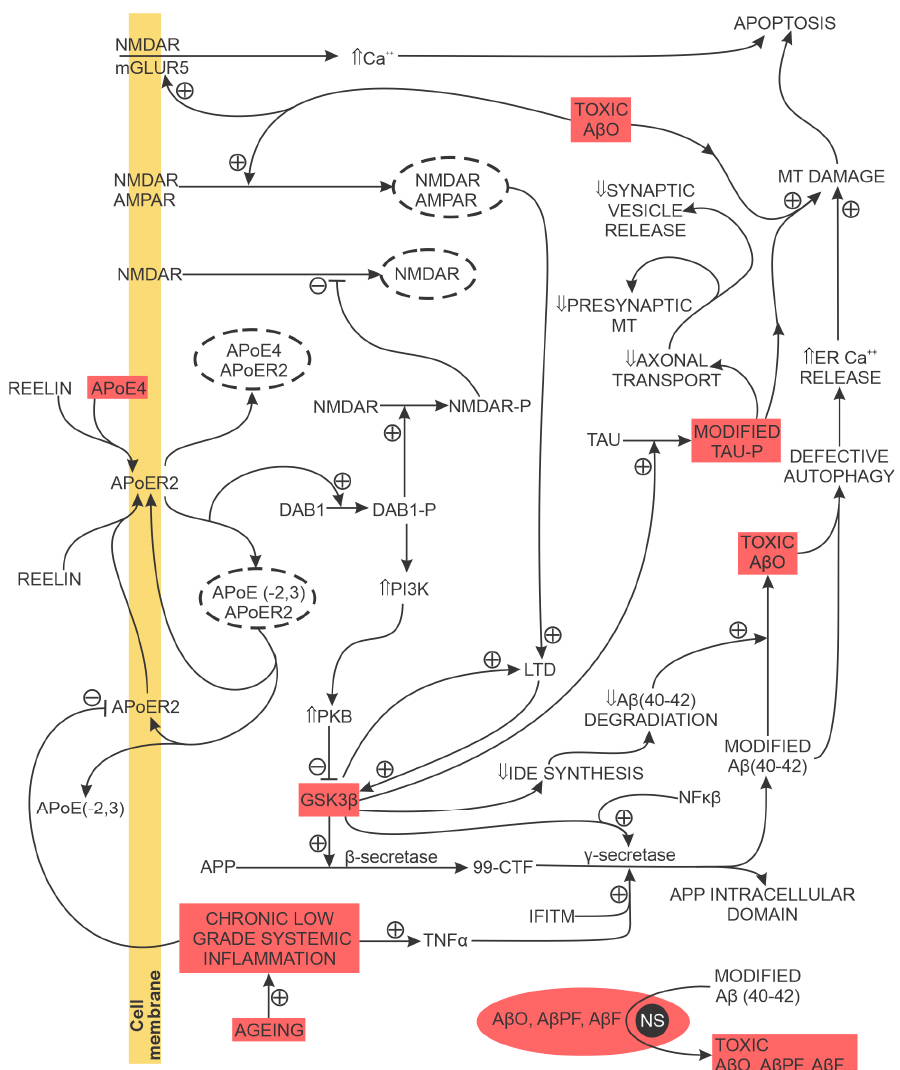
Figure 4. Toxic soluble A β O and truncated, misfolded, and hyperphosphorylated toxic tau oligomers are the critical drivers of synapse loss and neuronal death in AD. The transformation of normal tau to its toxic oligomers is promoted by increased GSK3 β activity; GSK3 β inhibits A β 42 degradation and promotes A β 42 production by stimulating β - and γ -secretase activity. Increased TNF α and IFITM levels also promote high GSK3 β activity. Ageing-associated chronic low-grade sterile inflammation and reduced reelin synthesis facilitate A β metabolism dysregulation. The secondary nucleation processes further accelerate the conversion of A β 42 peptides to toxic A β Os at the A β O, protofibril and fibril nucleation sites. Abbreviations: ⇑ (increased), ⇓ (decreased), + (stimulating effect), − (inhibitory effect), - - - - (dashed lines denote internalised molecules), 99-CTF (99-amino acid membrane-bound C-terminal fragment), A β 42 (an amyloid β peptide with 42 amino acid residues), A β O (amyloid β oligomers), AMPAR ( α -amino-3-hydroxy-5-methyl-4-isoxazolepropionic acid receptor), APP (amyloid precursor protein), A β F (amyloid β fibril), A β PF (amyloid β protofibril), APOE (apolipoprotein E), APOER2 (reelin apolipoprotein E receptor 2), DAB1 (DAB adaptor protein 1), DAB1-P (phosphorylated DAB adaptor protein 1), GSK3 β (glycogen synthase kinase 3 β ), IDE (insulin-degrading enzyme), IFITM (interferon-induced transmembrane protein), mGLUR5 (metabotropic glutamate receptor 5), NF κ B (nuclear factor kappa-light-chain-enhancer of activated B cells), NMDAR (N-methyl-D-aspartate receptor), NS (nucleation site), PI3K (phosphoinositide 3-kinase), PKB (protein kinase B), Tau-P (truncated, misfolded, and hyperphosphorylated tau), TNF α (tumour necrosis factor α